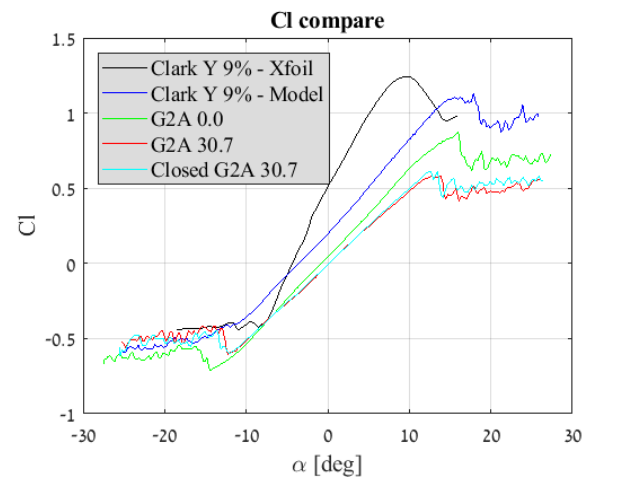
Figure 23. Lift coefficient vs. angle of attack comparison of the four tested wing segments.